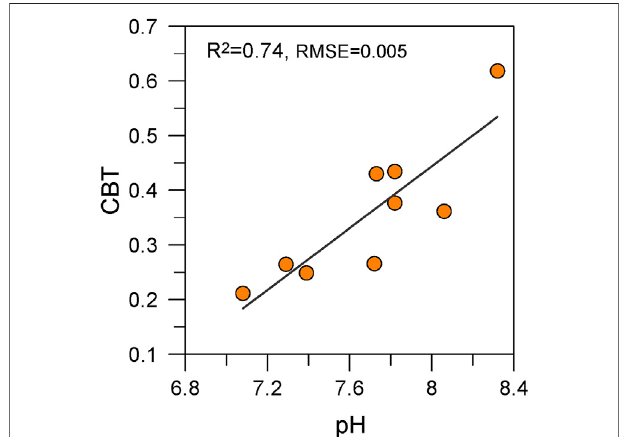
Frontiers in Earth Science |